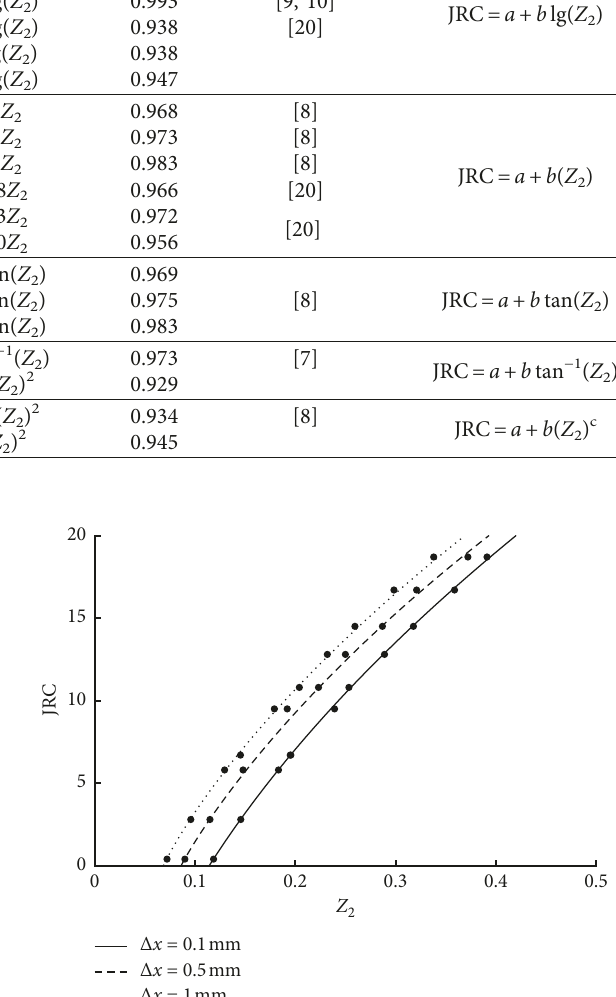
Figure 1: Relationship between the JRC and Z values.